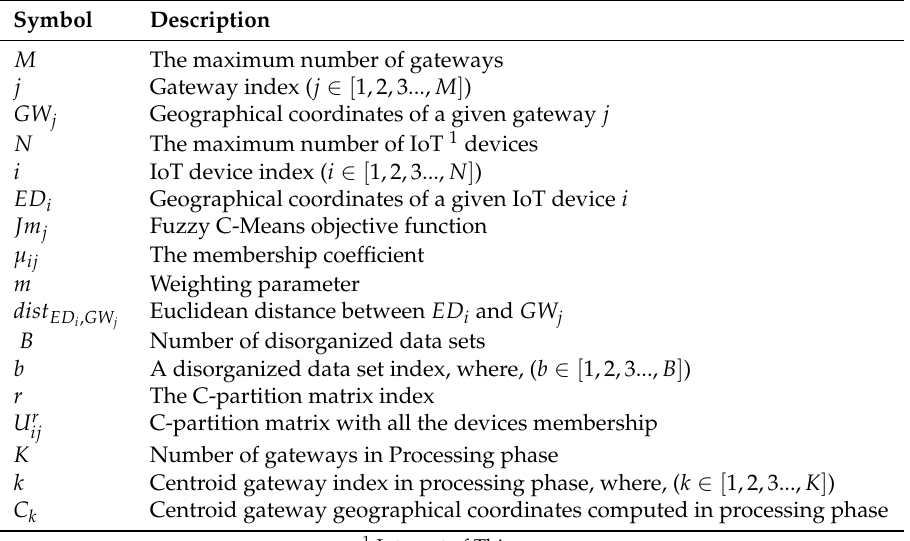
Table 2. Main symbols considered for DPLACE modeling.